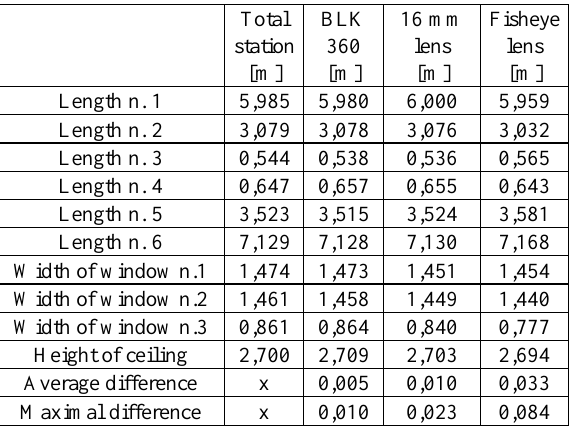
Table 10. Comparison of parameters of 3D models of the room created from point clouds and measurement with total